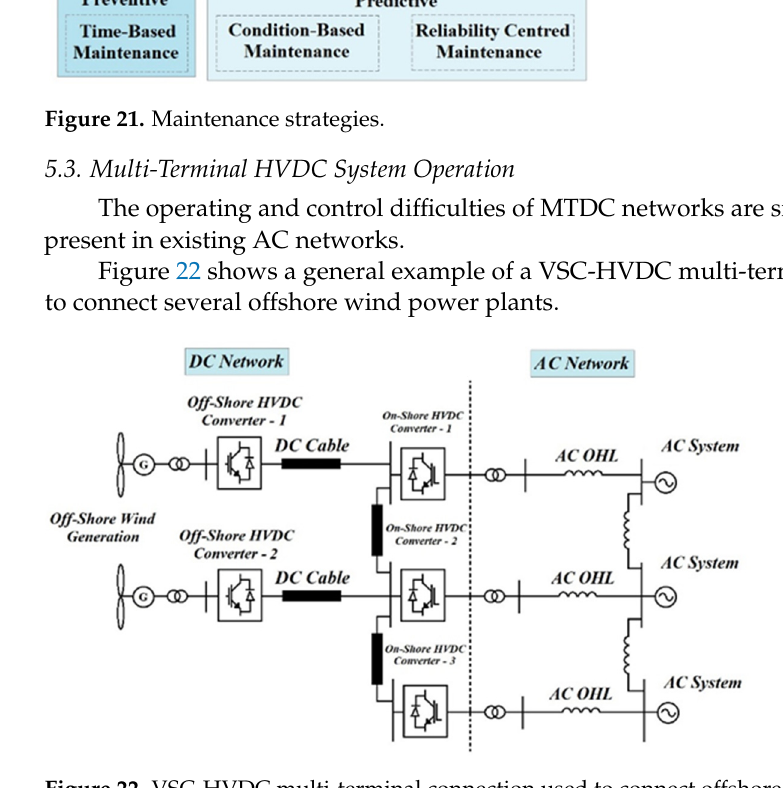
Figure 22. VSC-HVDC multi-terminal connection used to connect offshore wind power plants